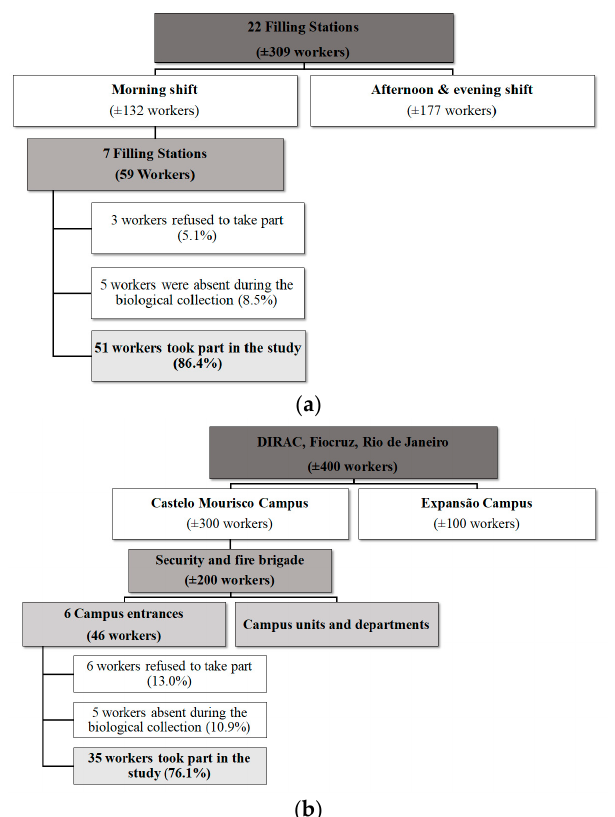
Figure 1. Diagrams of the selection of the two groups of workers exposed to benzene. ( a ) Group I: Workers of Filling Stations; ( b ) Group II: Workers of Campus Entrances. Workers of Filling Stations; ( b ) Group II: Workers of Campus